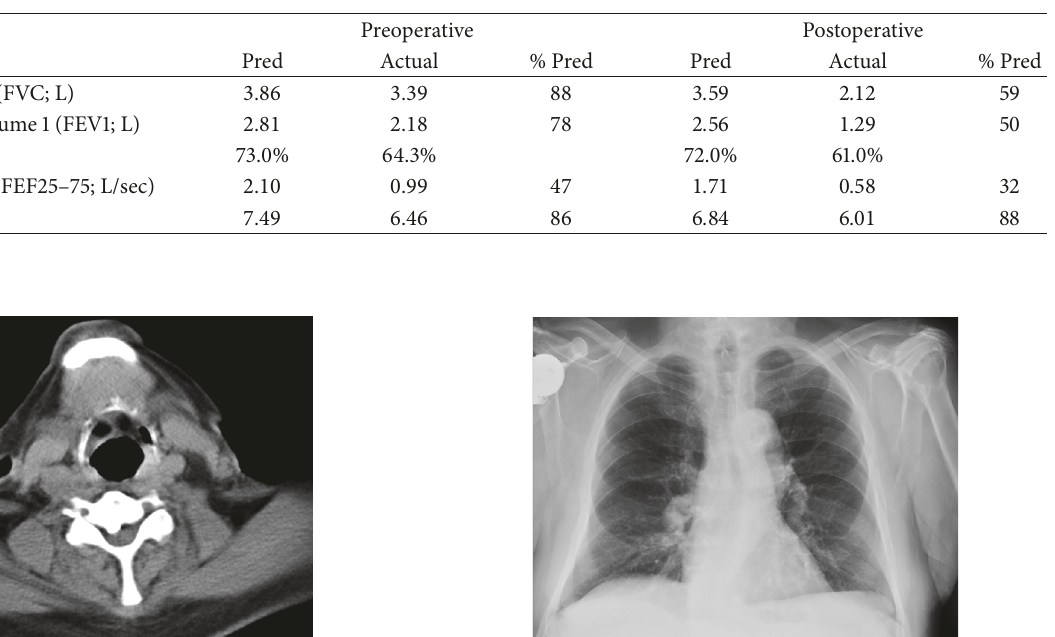
Table 1: Pulmonary function tests pre- and postoperatively.